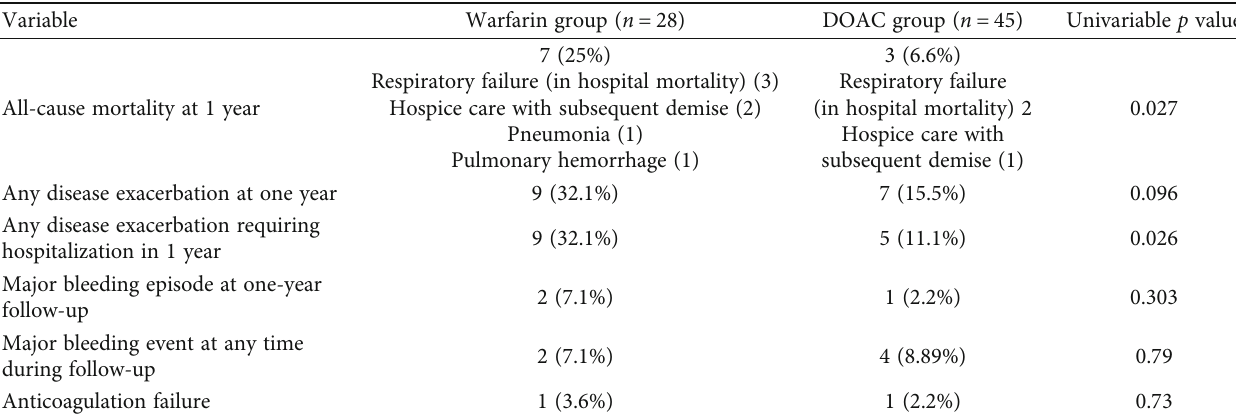
Table 2: Outcomes in the warfarin and DOAC